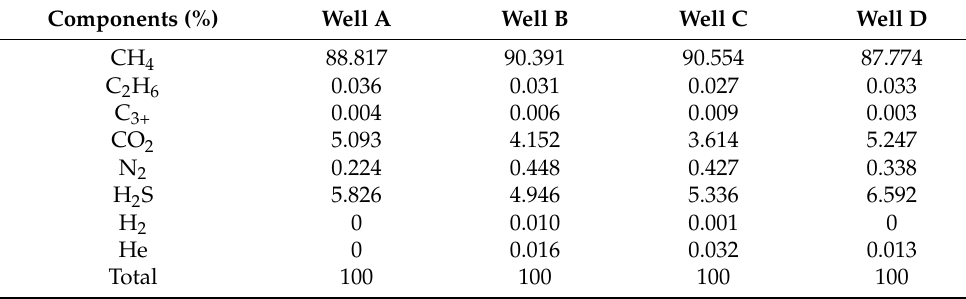
Table 5. Produced natural gas